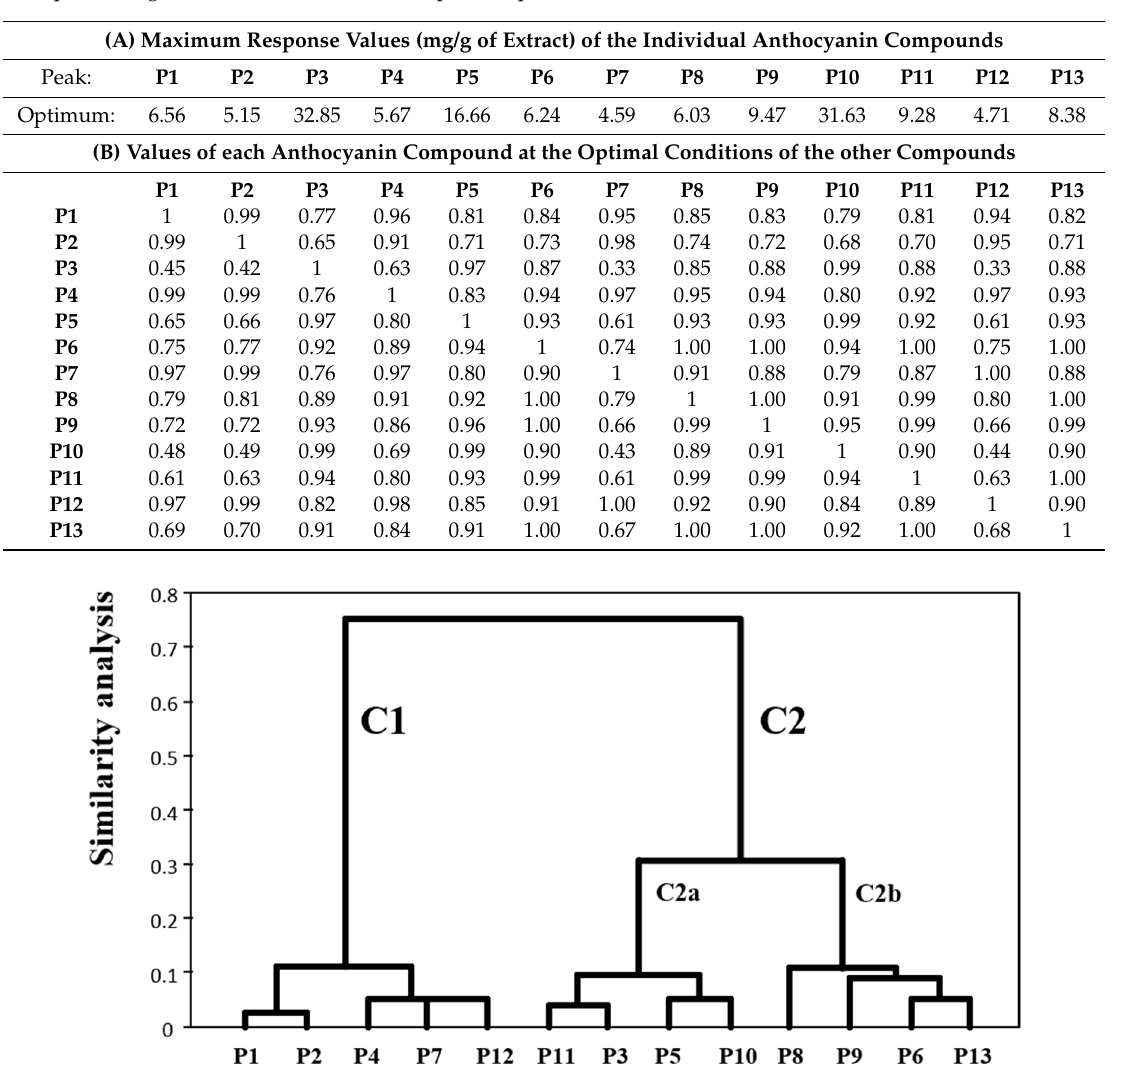
Table 5. Maximum response values of each anthocyanin compound and their values at the optimal processing conditions of the other compounds presented in Table 3.